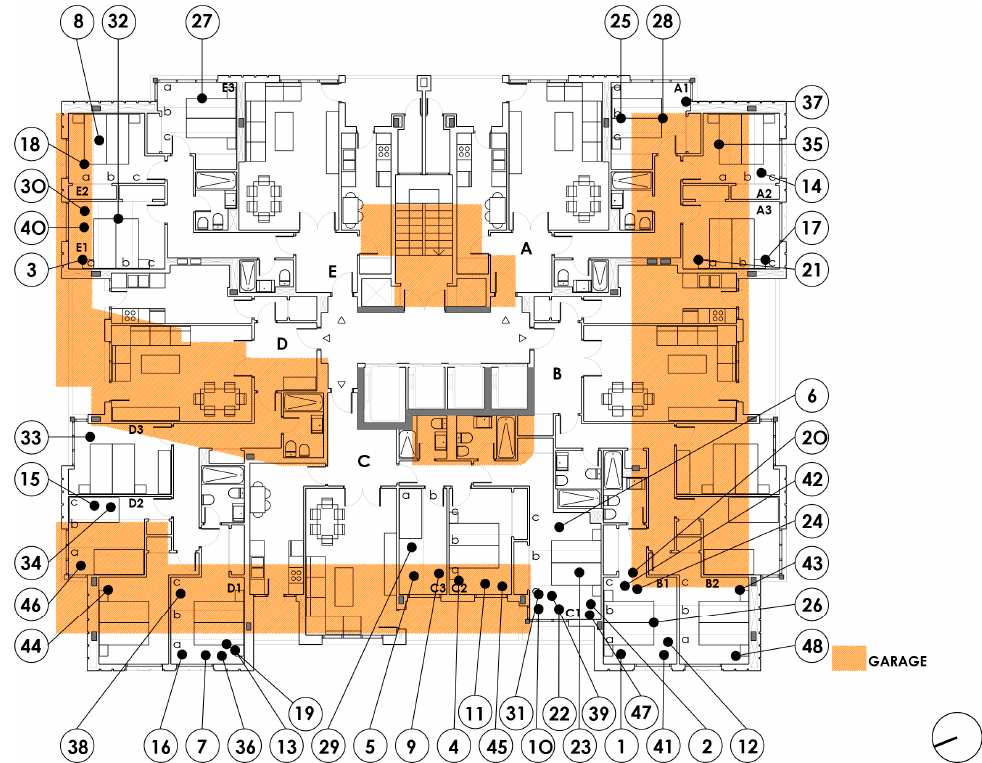
Figure 8 . Floor plan dwellings type 1 to 16. Overlapping garages. Figure 8. Floor plan dwellings type 1 to 16. Overlapping garages.